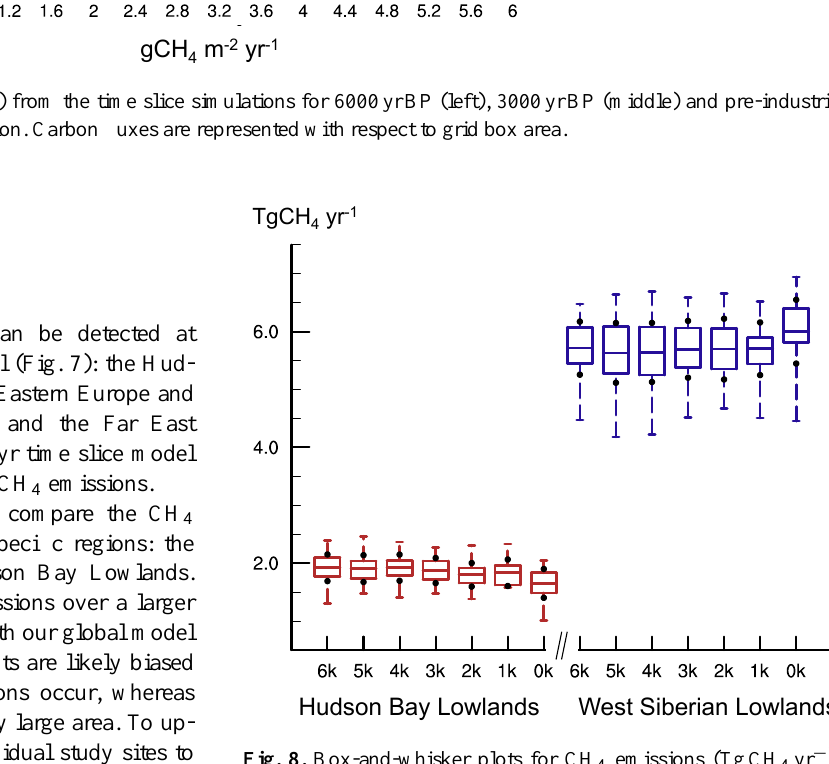
Fig. 8. Box-and-whisker plots for CH 4 emissions (TgCH 4 yr − 1 ) averaged over the regions of Hudson Bay (left, red) and West Siberian Planes (left, blue) as defined by Picket-Heaps (2011) and Winderlich (2011) for 6000yrBP to pre-industrial. The tailored box plots show the mean, minimum value, maximum value, and the 25th and 75th percentiles of a 30-yr time